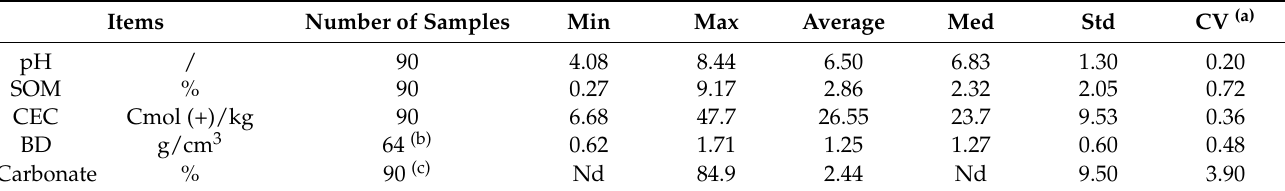
Table 1. Physical and chemical properties of the soil profile in the study area.